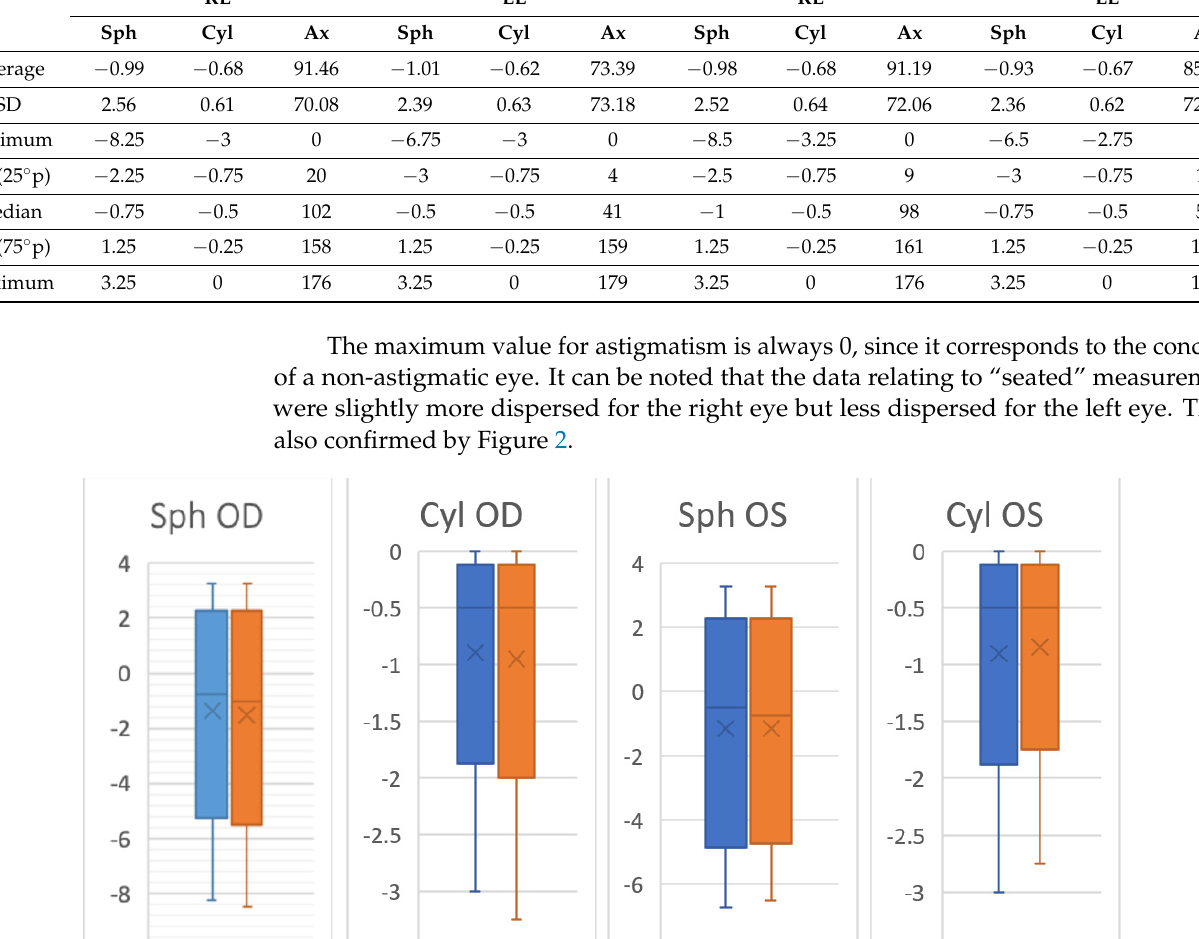
Table 1. Statistics in the standing and sitting positions. RE = right eye; LE = left eye; Sph = sphere; Cyl = cylinder; Ax = axis; SD = standard deviation; Q1 = first quartile (25%); Q3 = third quartile.